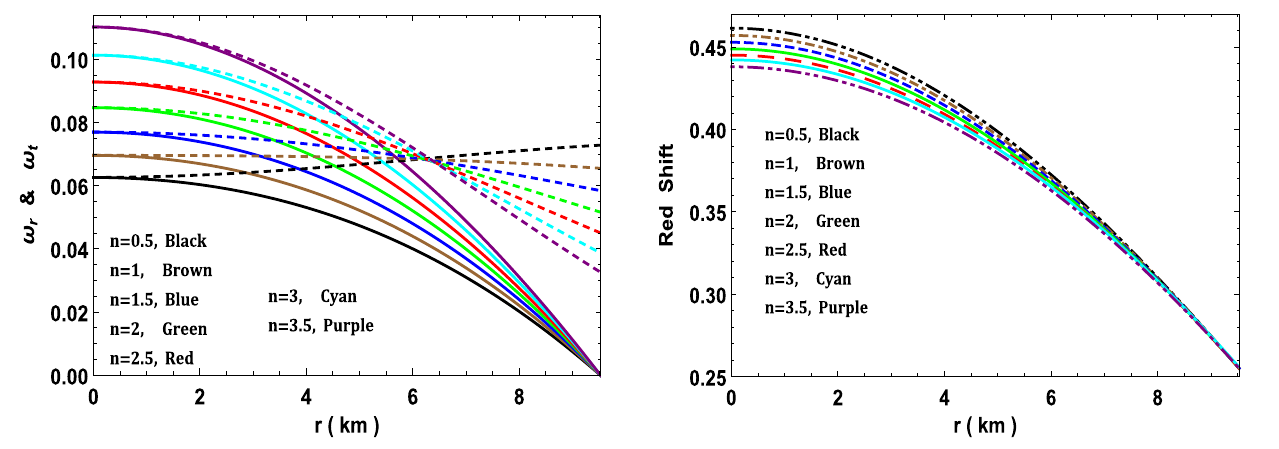
Fig. 6 Variation of red-shift with radial coordinate r for 4U 1608-52 ( M = 1 . 74 M (cid:9) , R = 9 . 528 km) by taking a = 0 . 001 km − 2 and β = 0 .